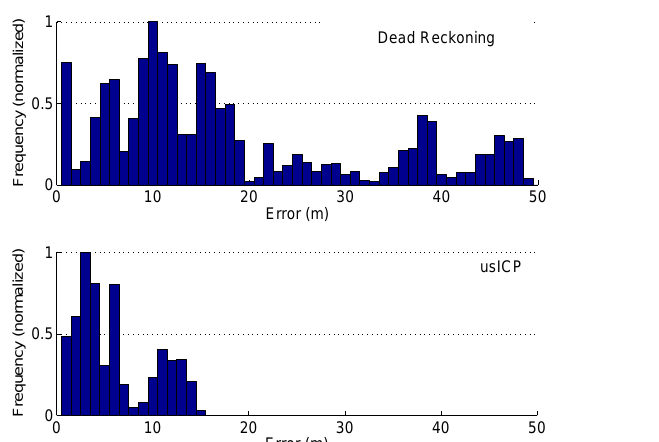
Figure 16. Histogram of the error for dead reckoning, MSISpIC, usICP and uspIC. The error frequency has been normalized for clarity